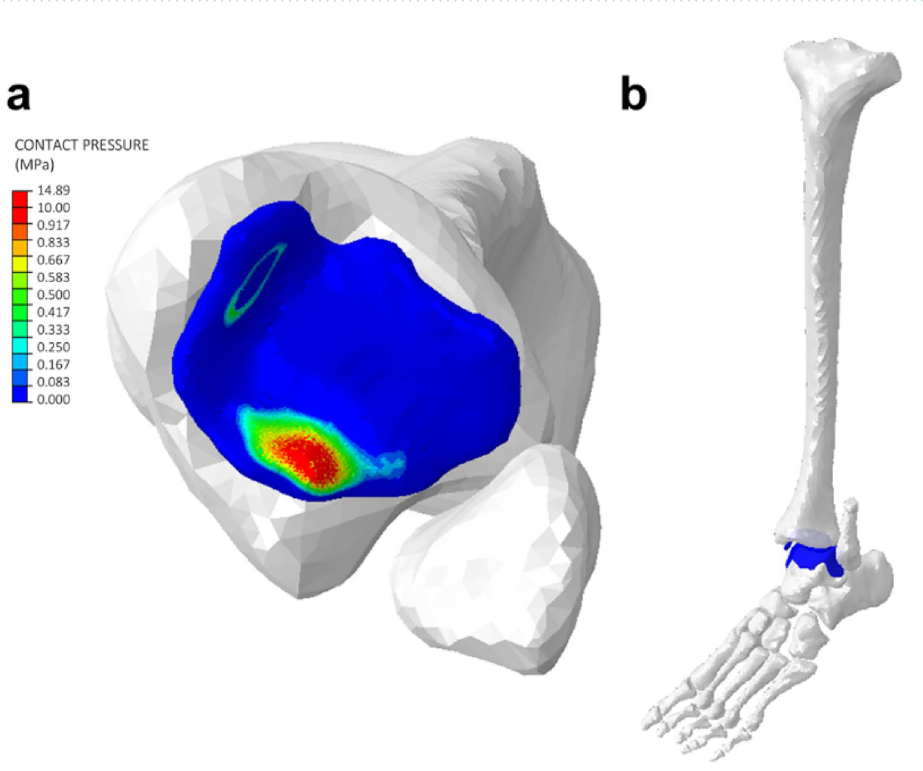
Figure 5. ( a ) Contour map from Abaqus (version 2020; https:// www. 3ds. com) simulation integrated with NEURON (version 7.7.2) showing contact pressure on the tibia articular cartilage during ankle plantarflexion. The region of higher contact pressure is located posteriorly. ( b ) Plantarflexed position of the tibia-talus